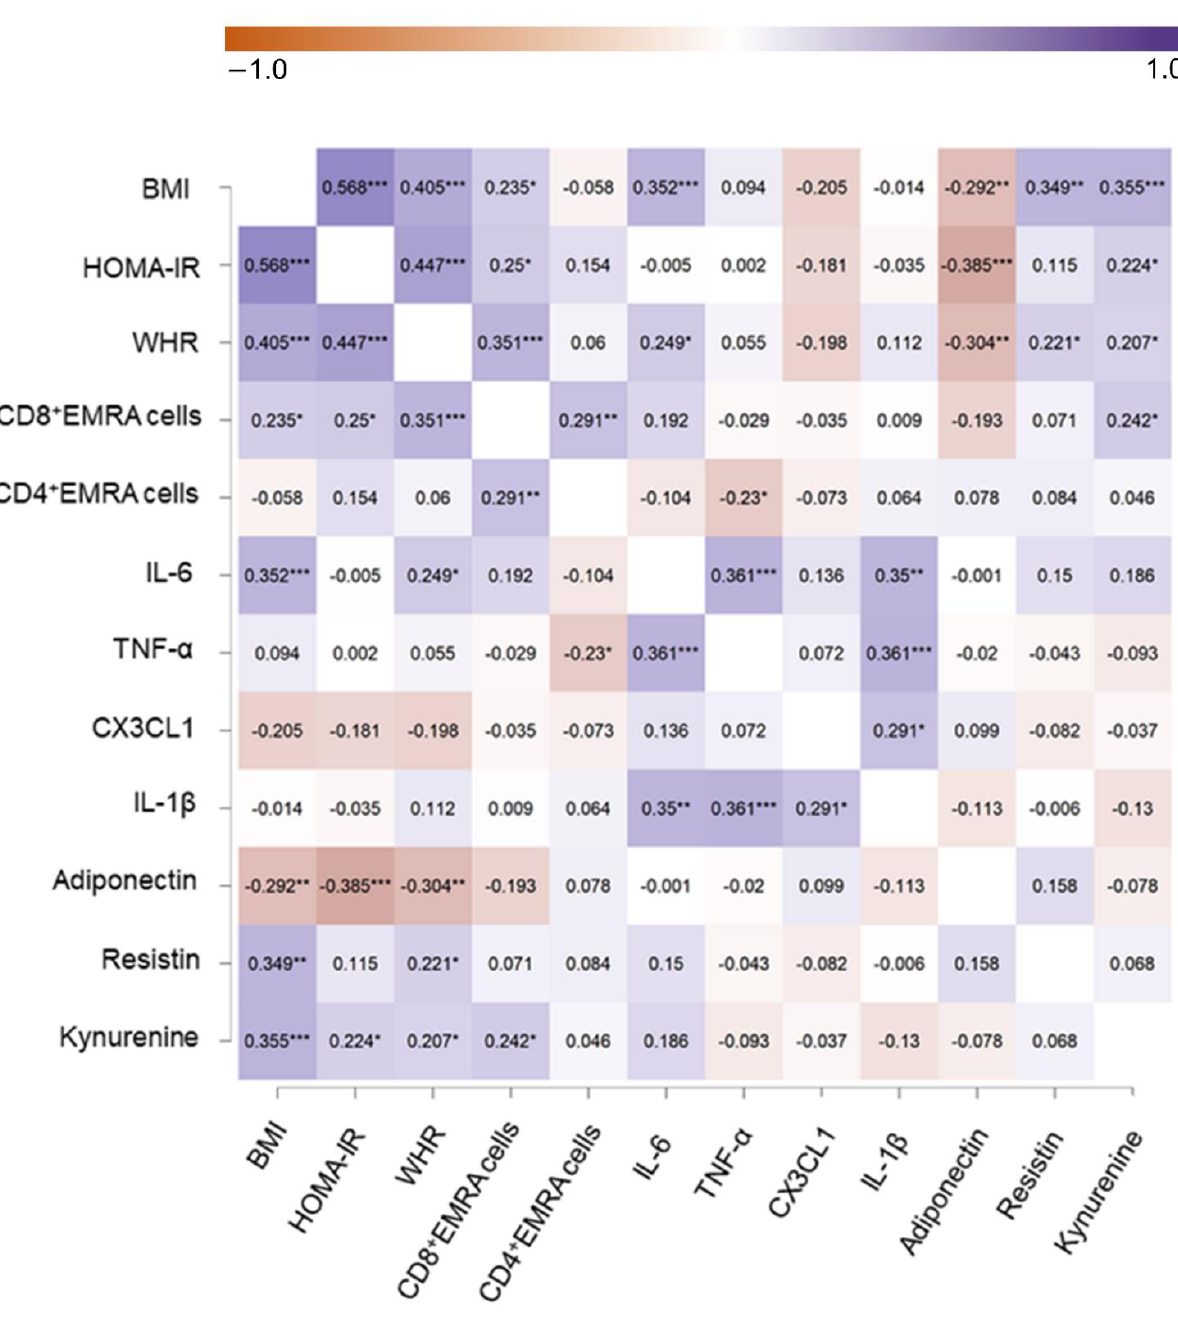
Figure 3. Correlation heat map including BMI, HOMA-IR, WHR, CD8+ and CD4+EMRA cells, IL-6, TNF- α , CX3CL1, adinopectin, resistin, and KYN. Raw p values of Spearman’s rank s correlations are presented. * means p < 0.05, ** means p < 0.01, *** means p < 0.001 not corrected for multiple tests.